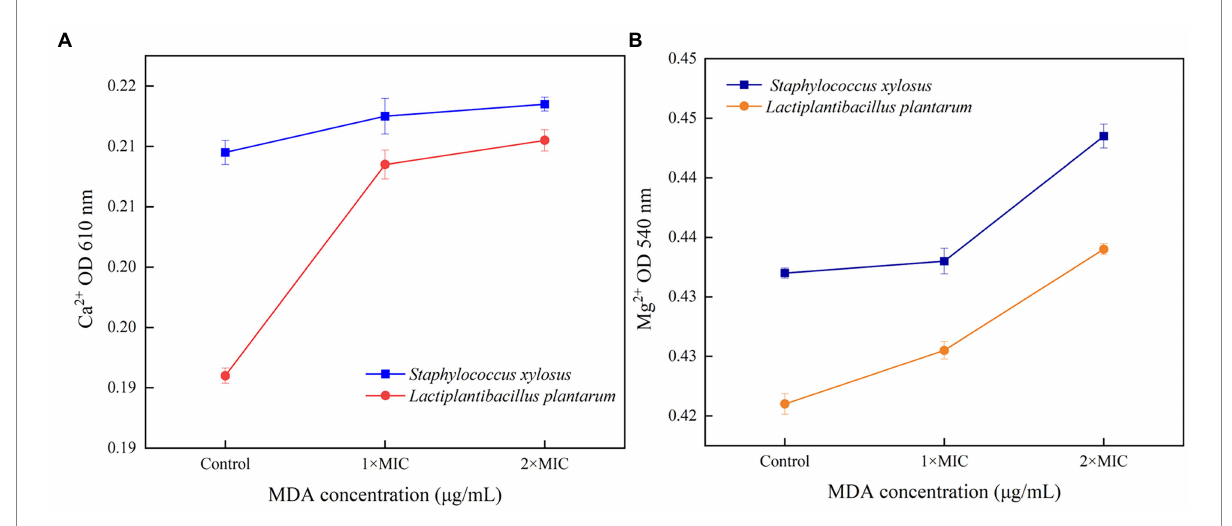
FIGURE 3 Release of Ca 2+ (A) or Mg 2+ (B) from S. xylosus and L. plantarum treated with